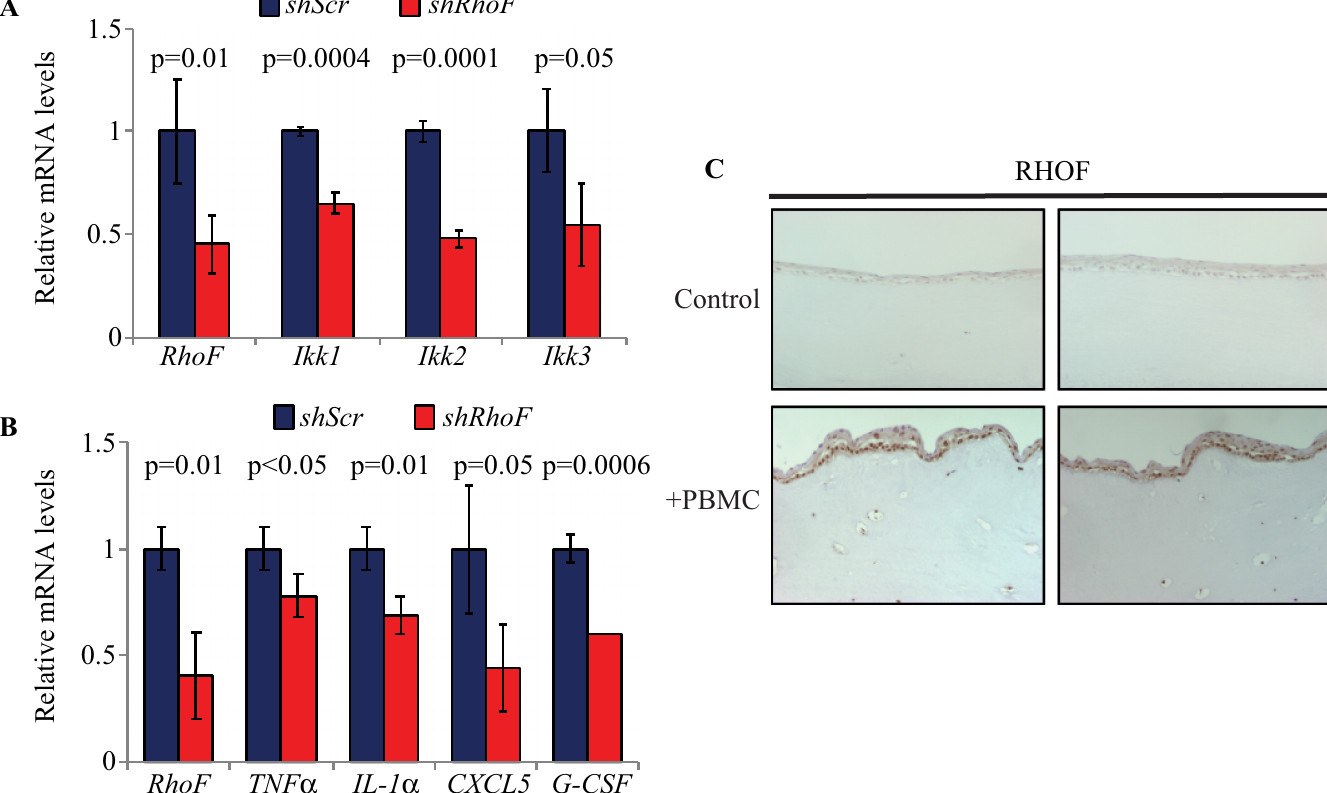
Fig 3. RHOF is upregulated in inflammation and activates pro-inflammatory cytokines. ( A ) By qPCR, expression of the NF κ B activators Ikk1 , Ikk2 , and Ikk3 decreased when RhoF was knocked down by shRNA in primary esophageal epithelial cells from wild-type mice, compared to similar cells infected with scrambled controls (shScr). ( B ) Compared to cells with shScr, primary mouse esophageal epithelial cells with shRNA against RhoF also had reduced expression of pro- inflammatory TNF α , IL-1 α , CXCL5 , and G-CSF . ( C ) When human primary esophageal epithelial cells were grown in organotypic culture with PBMCs that were stimulated with IL-2, IL-7, and IL-15, RHOF levels increased markedly within epithelial cells, compared to cells grown without PBMCs.